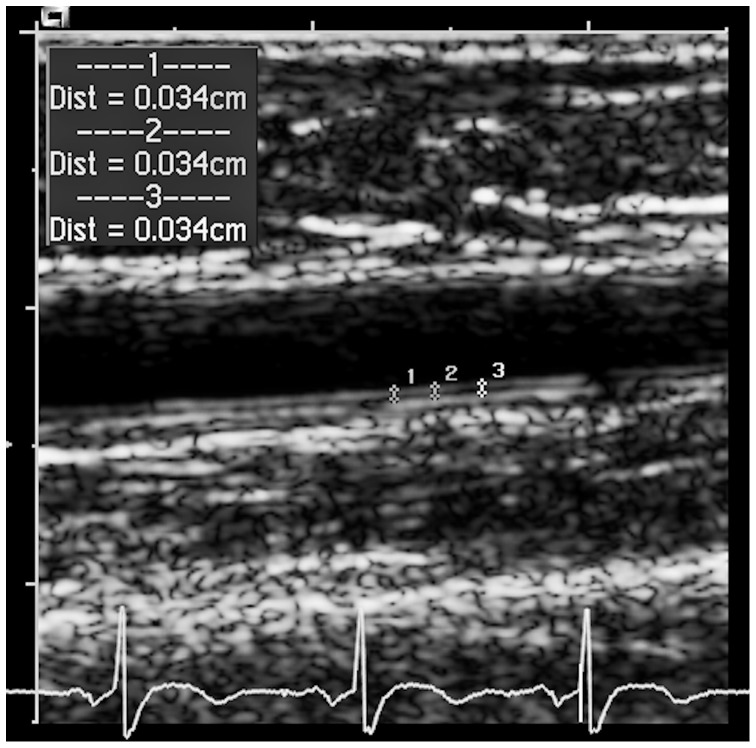
Grey scale ultrasound image of the right brachial artery of a 74-year-old female patient.Brachial IMT is measured three times in a one-centimeter-long segment. ECG triggering indicates the measurement in the enddiastolic phase.